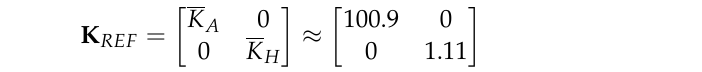
Table 4. Main properties of the upscaling techniques discussed in this paper. Properties of the Method